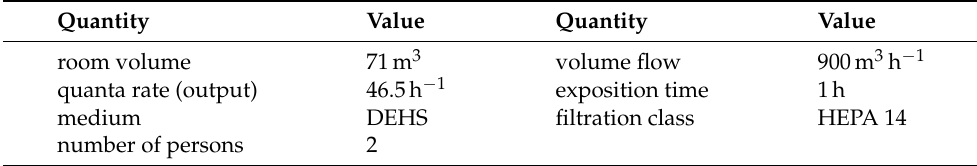
Table 3. Relevant parameters of the experiments concerning the effectiveness of air purifiers. Quantity